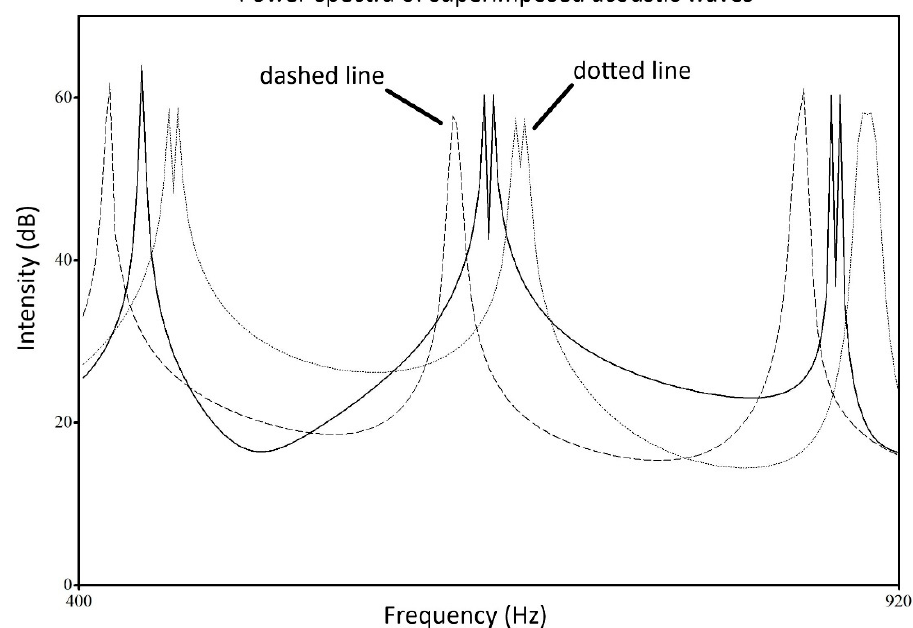
Figure 10. Power spectra (generated and displayed using Praat) of acoustic waves generated by superimposition of two artificially generated waves having the same basic frequency (220 Hz), but with different frequencies for the next three overtones (441, 662, and 883 Hz and 439, 658, and 878 Hz). The two artificial waves used for the superimposition had either no systematic frequency jitter (solid line), an identical systematic frequency jitter (dotted line), or a different systematic frequency jitter (dashed line). For better visibility, the x -axis of the spectra with frequency jitter is shifted by 20 Hz.